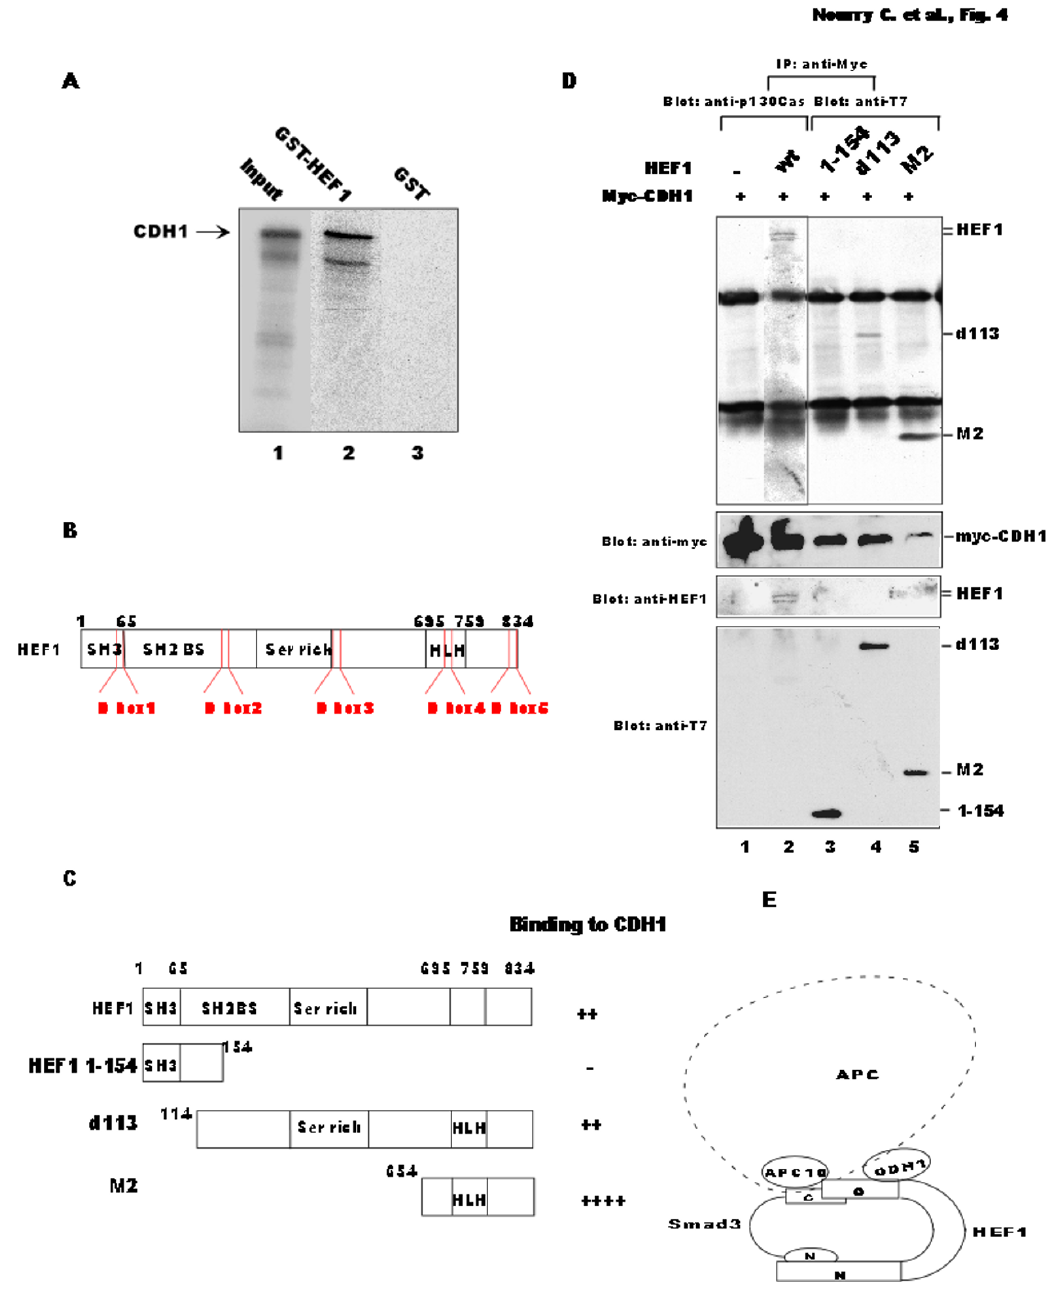
Figure 4 CDH1 interacts with HEF1 at the HEF1 C-terminal M2 domain. (A) In vitro binding test. In vitro translated 35 S labeled CDH1 was incubated with GST-HEF1 or GST alone as a control in modified lysis buffer. 35 S labeled CDH1 was sepa- rated by electrophoresis and detected by autoradiography. (B) A cartoon that illustrates putative D boxes on HEF1. (C) A car- toon that illustrates the deletion constructs of HEF1 used in (D). (D) Co-immunoprecipitation of HEF1/HEF1 deletions with CDH1 in 293 cells. Full-length HEF1 and T7-tagged HEF1 deletions were co-transfected with myc-tagged CDH1 into 293 cells. Myc-CDH1 was immunoprecipitated with anti-myc antiboby and CDH1 bound HEF1 or HEF1 deletions were detected by immunoblot with either anti-p130Cas antibody (top panel, lanes 1 & 2) or anti-T7 antibody (top panel, lanes 3–5). The expres- sion level of CDH1 was detected with anti-myc antibody (second panel). The amount of HEF1 (third panel) or T7-HEF1 dele- tions (bottom panel) expressed was detected by anti-p130Cas for HEF1 or anti-T7 antibody. (E) A cartoon that illustrate the putative complex of HEF1, Smad3, APC and